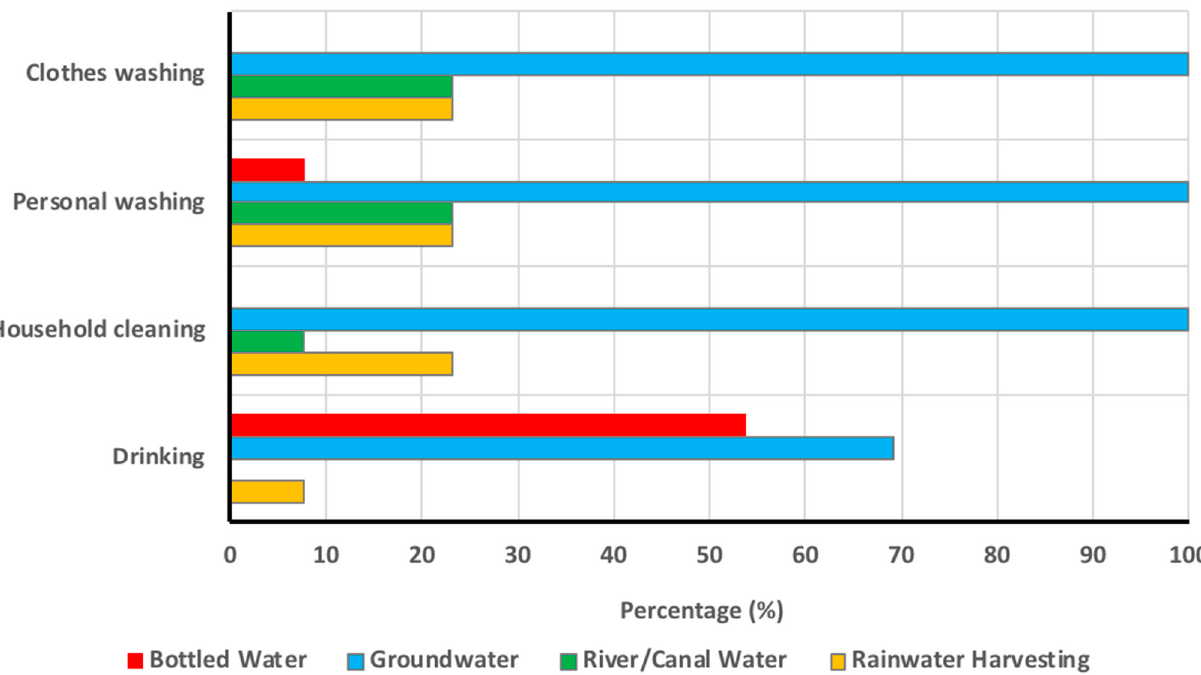
Figure 6. Main sources (%) of fresh water for domestic and drinking water use in the study area, based on the answers of the interviewees. In the questionnaire, multiple answers were allowed.